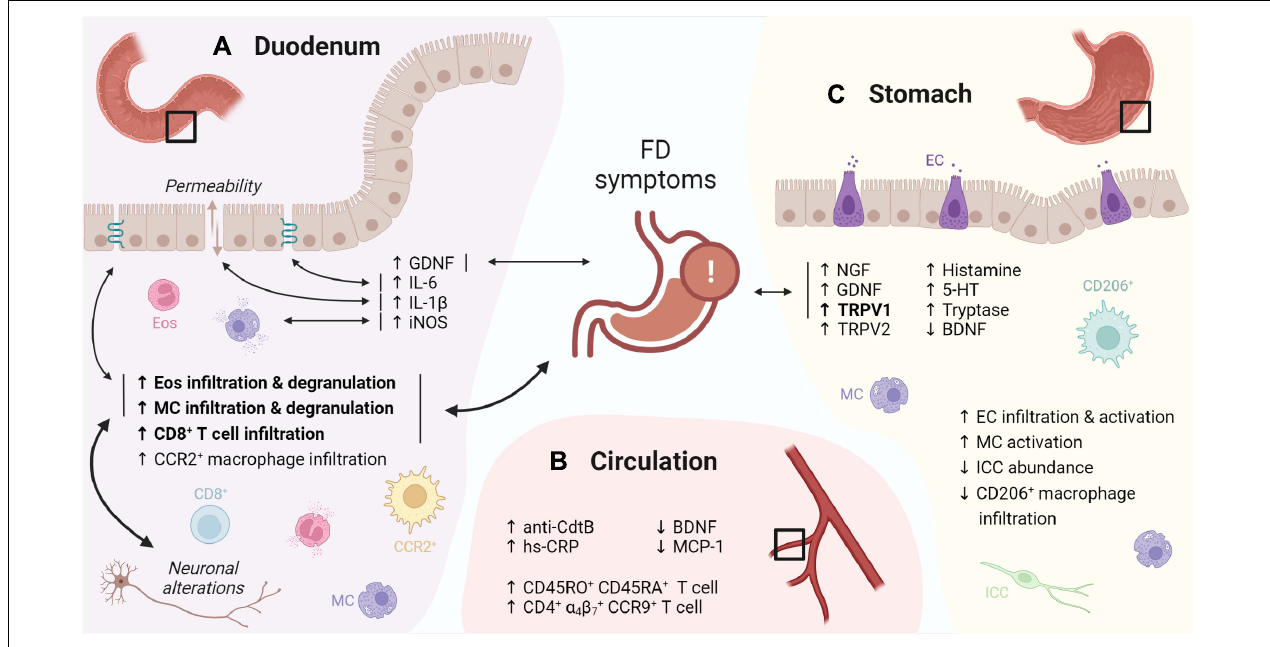
FIGURE 1 | Graphical overview of the evidence for immune activation in FD. (A) The duodenal immune infiltrate in FD is characterized by increased eosinophil and MC infiltration and degranulation, linked to FD symptoms, neuronal alterations and changes in TJ gene expression. Increased levels of GDNF, IL-6, -1 β and iNOS were linked to FD symptoms, TJ gene expression, increased permeability and mast cell degranulation, respectively. (B) Increased CD45RO + CD45RA + and gut-homing ( α 4 β 7 + CCR9 + ) lymphocytes were reported in the peripheral circulation of FD patients. In addition, increased anti-CdtB antibodies and hs-CRP, as well as decreased BDNF and MCP-1 were described. (C) Gastric immune alterations in FD include increased EC infiltration and activation, increased MC activation as well as decreased CD206 + macrophage and ICC abundance, although none were linked to symptoms. Increased gastric NGF, GDNF and TRPV1 levels in FD patients were associated to symptoms, along with increased TRPV2, histamine, 5-HT, tryptase and decreased BDNF. Confirmed findings are in bold. Double-headed arrows indicate associations, with confirmed associations in bold. FD: functional dyspepsia, MC: mast cell, TJ: tight junction, GDNF: glial cell-derived neurotrophic factor, iNOS: inducible nitric oxide synthase, CdtB: cytolethal distending toxin B, hs-CRP: high-sensitivity C-reactive protein, BDNF: brain-derived neurotrophic factor, MCP: monocyte chemoattractant protein, EC: enterochromaffin cells, ICC: interstitial cell of Cajal, NGF: nerve growth factor, TRPV: transient receptor potential vanilloid, 5-HT: serotonin. This figure was created in BioRender.